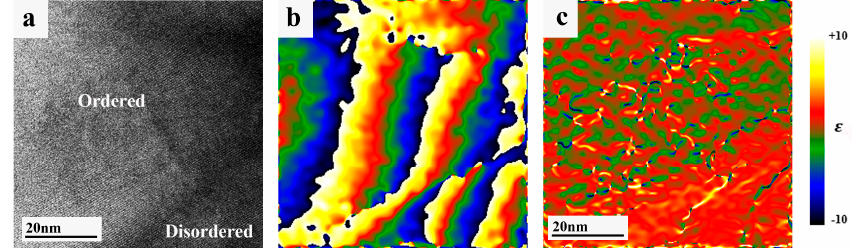
Figure 6. ( a ) HRTEM image of the interface between the disordered (due to irradiation) and ordered U(Al, Si) 3 phases taken at [ 101 ] and [ 201 ] orientations, respectively; ( b ) geometric phase map calculated from the HRTEM image using GPA. Differences in colors correspond to the phase change. Absolute values of the phase here are not important; and ( c ) the strain map. The legend of this map is shown on the right. It can be seen that area in the right lower corner of the map is less strained with